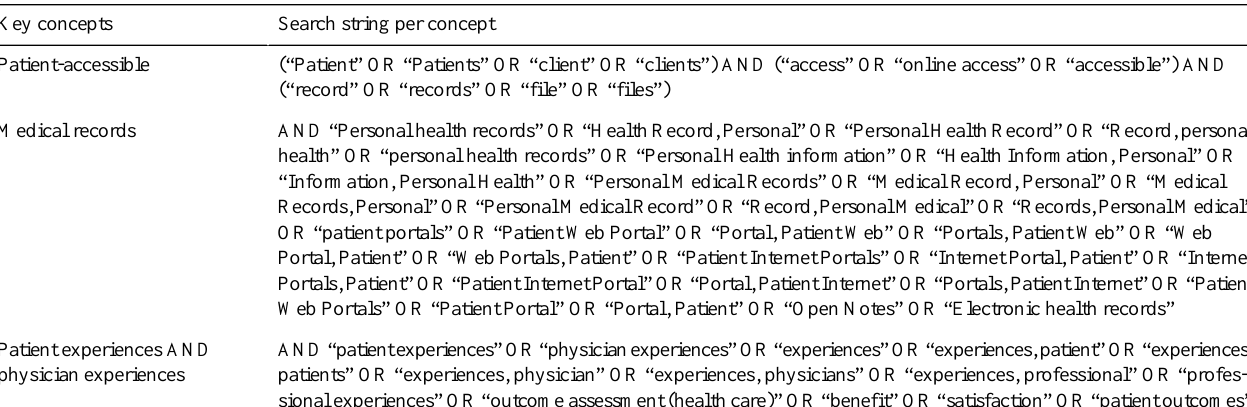
Search string per conceptKey concepts